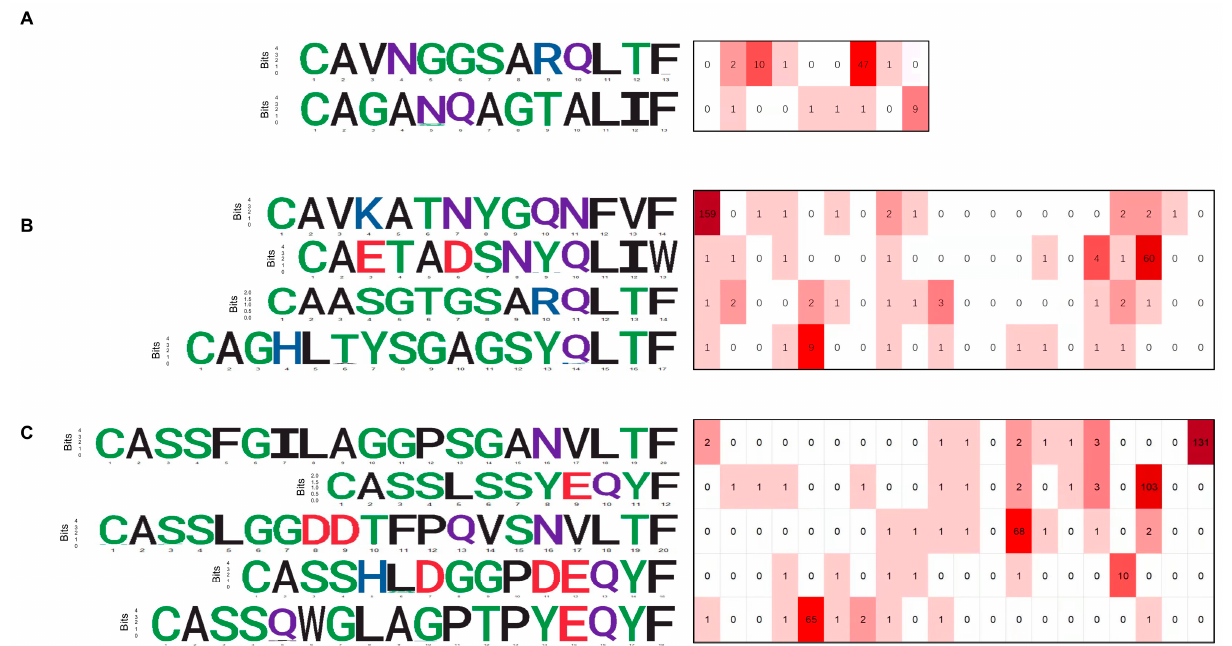
Figure 4. The unique TCR sequence motif and epitope specificity of CD8 + T cell clones in COVID-19 patients with 2-week and 6-month convalescence phase. ( A ) The dominant CDR3 motif of TRA in COVID-19 patients with 2-week convalescence phase. ( B ) The dominant CDR3 motif of TRA in COVID-19 patients with 6-month convalescence phase. ( C ) The dominant CDR3 motif of TRB in COVID-19 patients with 6-month convalescence phase.